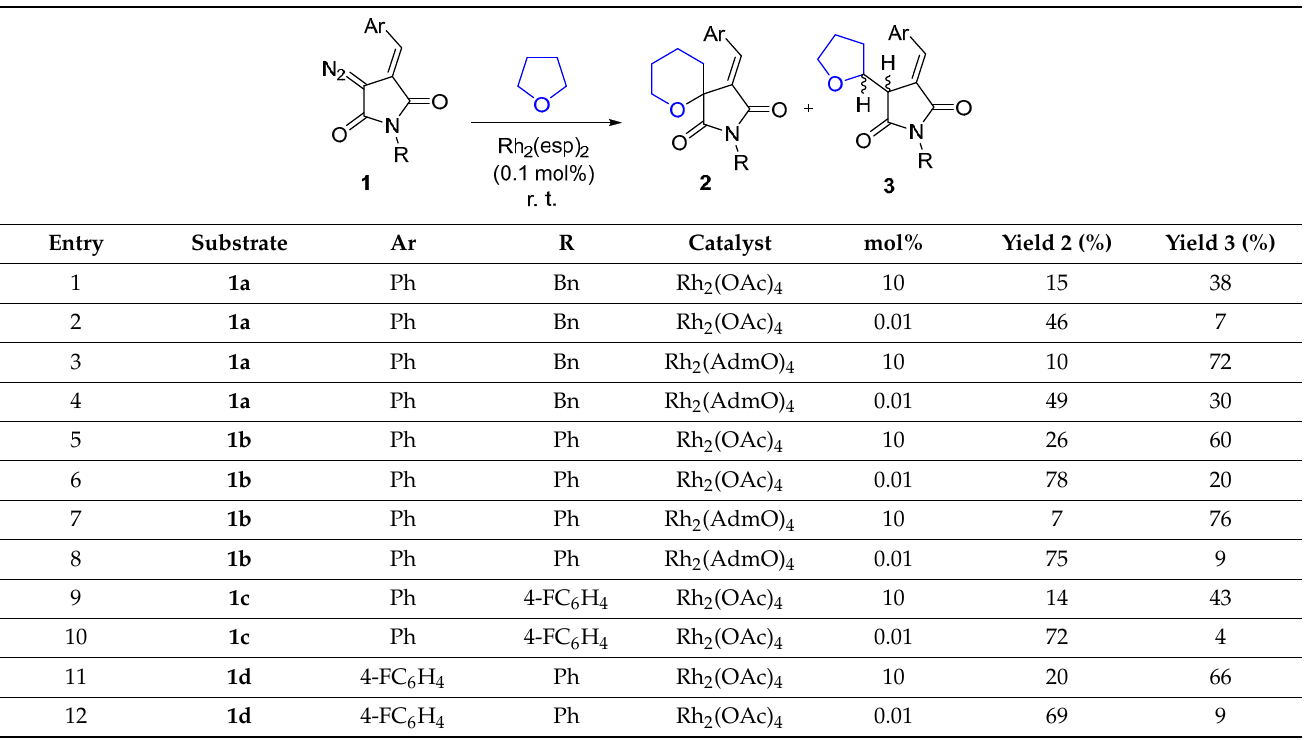
Table 3. Preparative (isolated) yields of products 2 and 3 in the reactions of DAS substrates with THF in the presence of varying Rh(II) catalyst loadings.